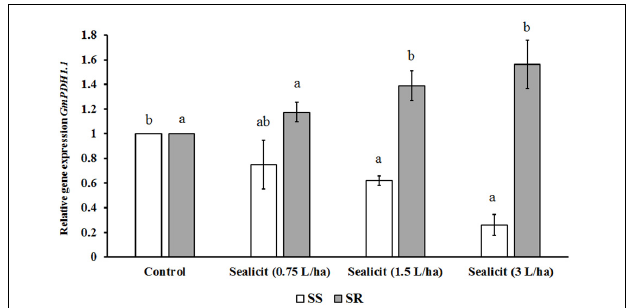
FIGURE 3 | Relative expression of GmPDH1.1 in soybean pods treated with Sealicit TM . Different letters within the same soybean variety indicate statistically significant differences between the treatments based on one-way ANOVA Tukey’s HSD test at p ≤ 0.05. Number of biological replicates ( n = 3).